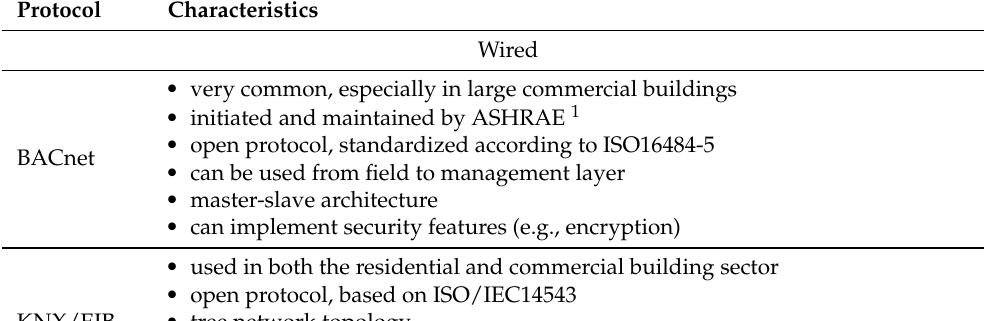
Table 1. Communication protocols of common wired and wireless devices used in sensor and control networks, based on